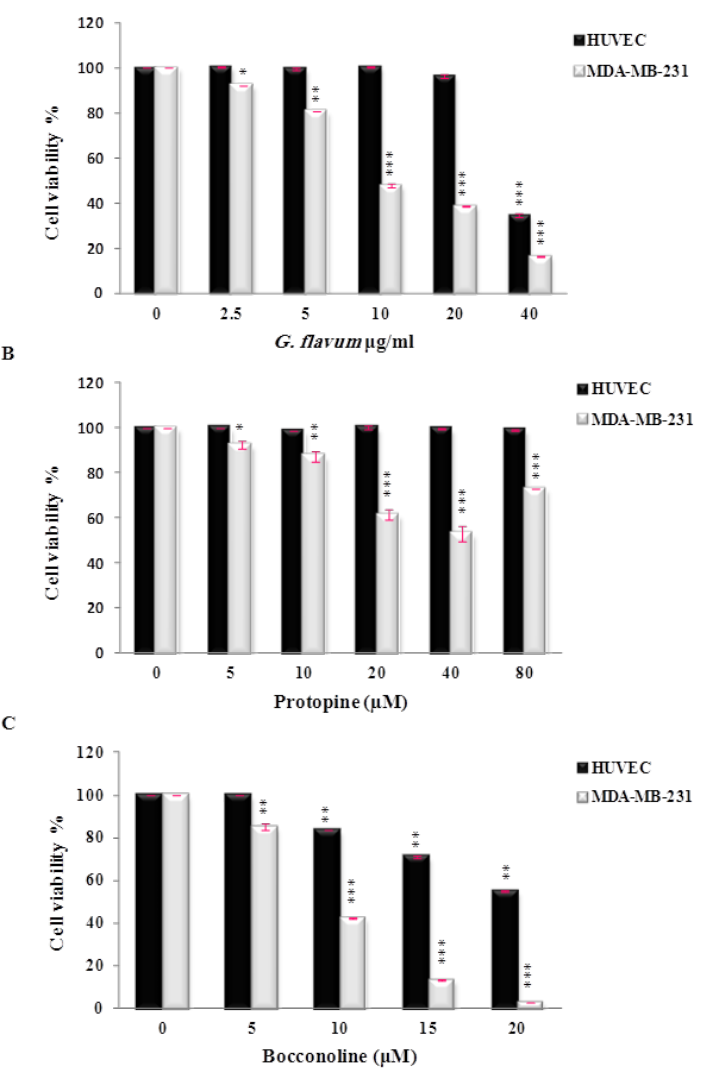
Figure 4. In vitro growth inhibitory activity of G . flavum alkaloids root extract ( A ), protopine ( B ), and bocconoline ( C ) against malignant human breast cancer cells (MDA-MB-231) and Human Umbilical Vein Endothelial Cells (HUVEC). Cells were treated with DMSO vehicle or the indicated concentrations of G . flavum alkaloids root extract, protopine and bocconoline for 24 h. Cell viability was determined using WST-1 assay and expressed as means ± S.E.M of three separate experiments ( n =